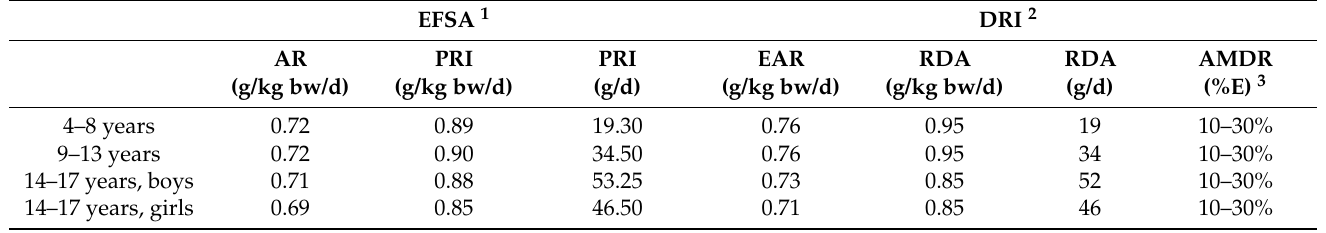
Table 1. Current recommendations for protein requirements, estimated by age and sex, for children. EFSA 1 DRI